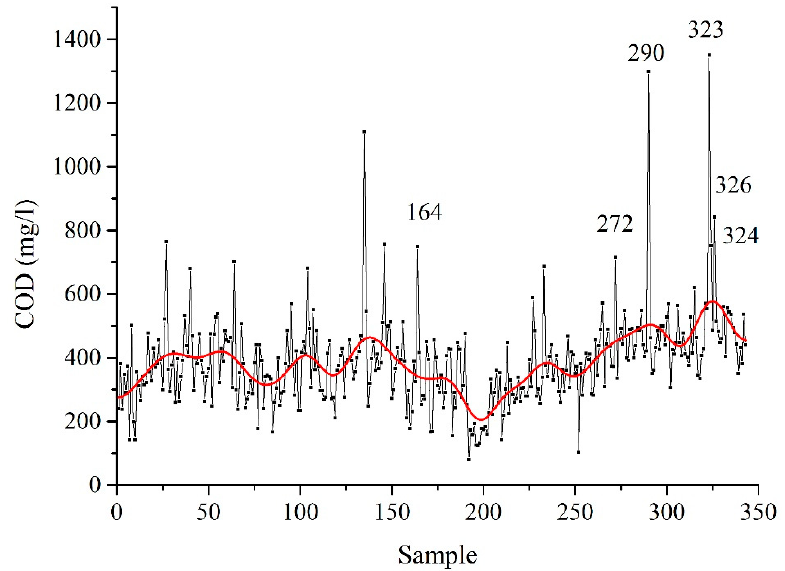
Figure 3. Chemical oxygen demand (COD) plot of wastewaters during year. The labels identify the